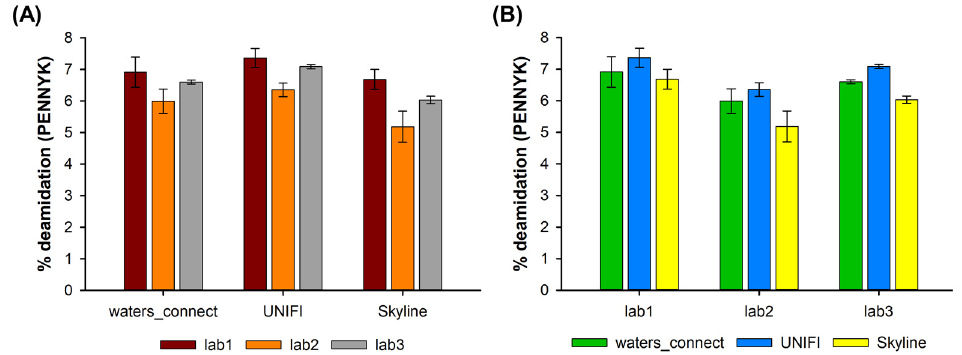
Figure 2. Percentage of deamidation observed on the PENNYK peptide in the high pH-stressed sample for the peak eluting at 34.30 min evaluated ( A ) by using three different software solutions (waters_connect, UNIFI and Skyline) on data obtained in ( B ) three different laboratories (lab1, lab2, and lab3).